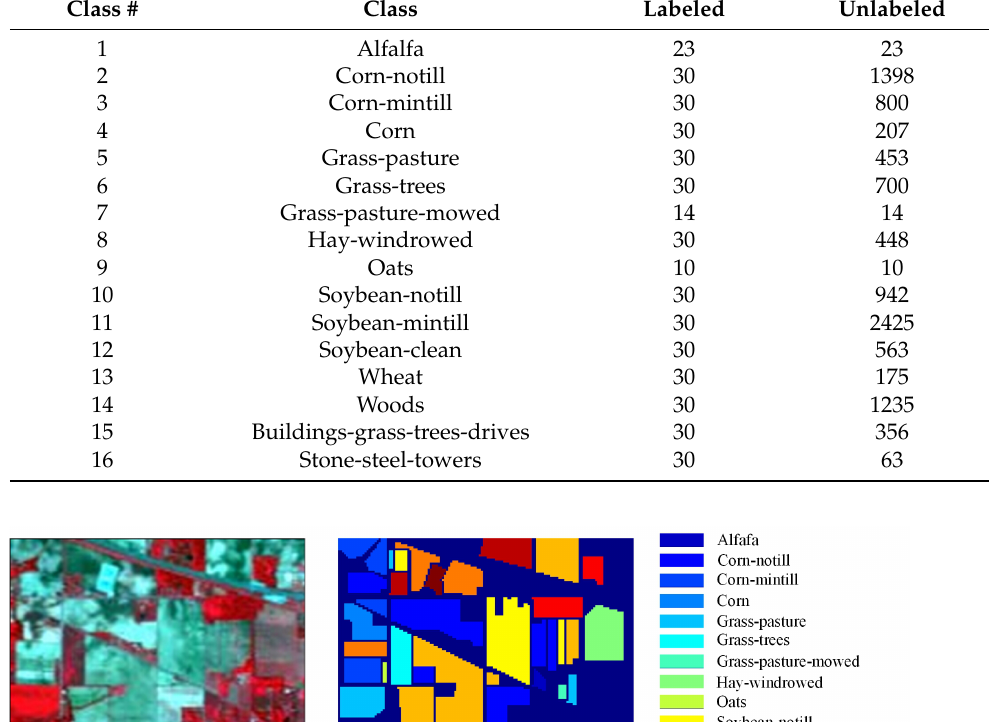
Table 1. Numbers of labeled and unlabeled samples for Indian Pine Dataset.